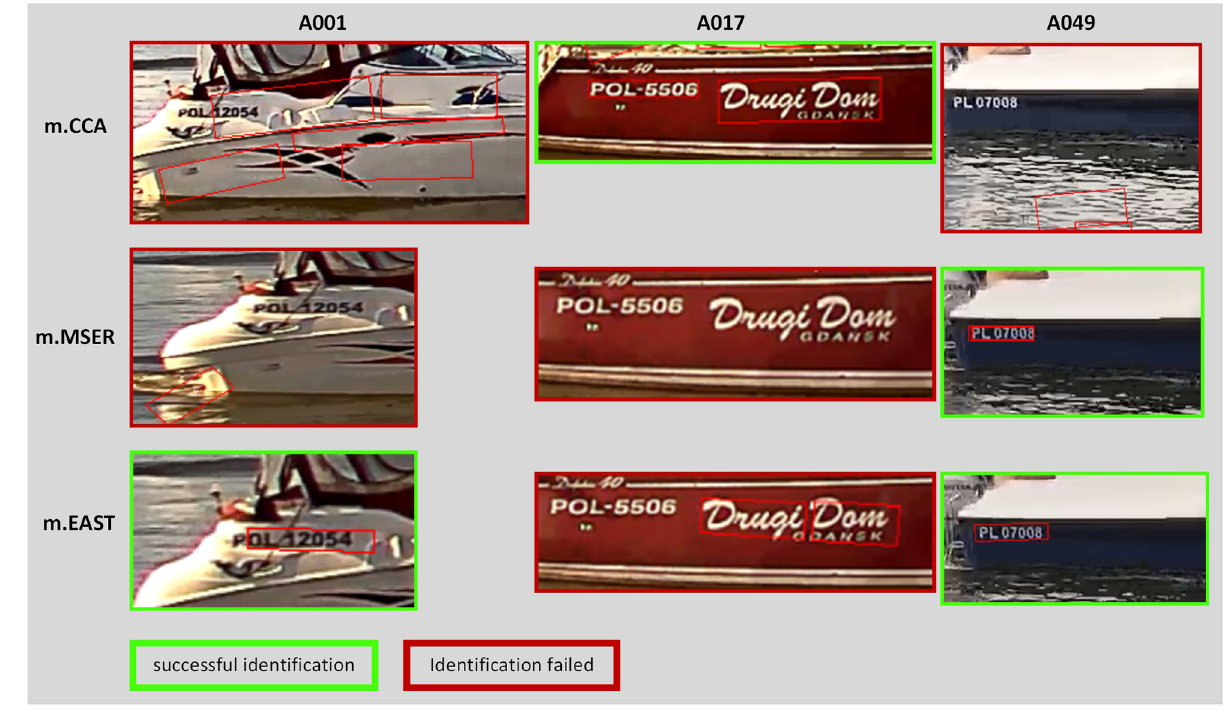
Fig 6. Examples of text localization in dataset A.